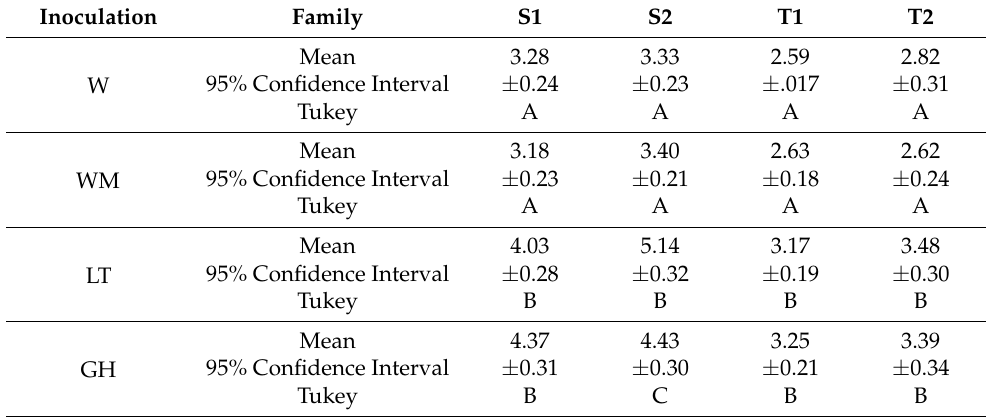
Table 10. Summary of lesion length/seedling height ( × 100) by family and inoculation treatment. Inoculation Family S1 S2 T1 T2 Mean W